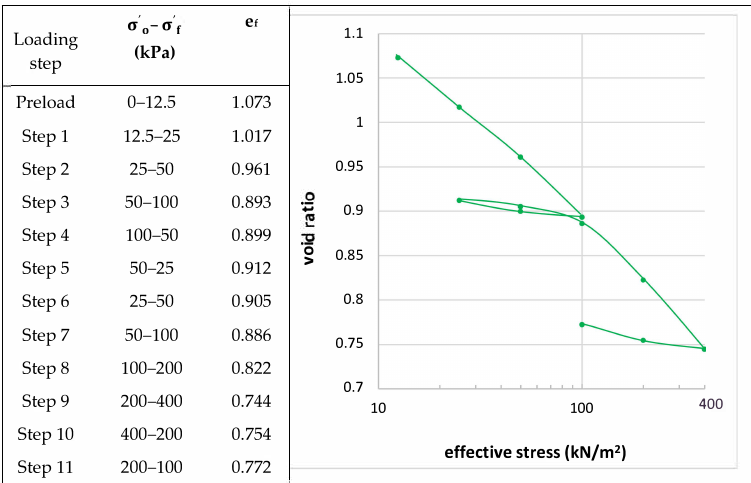
Figure 3. Compressibility curve of the clayey soil with a high content of muscovite.